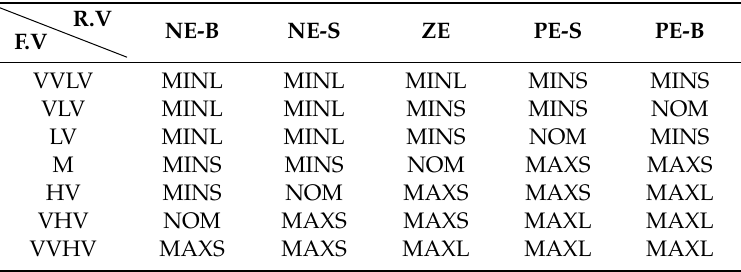
Table 5. Rules for fuzzy—Rule 3.